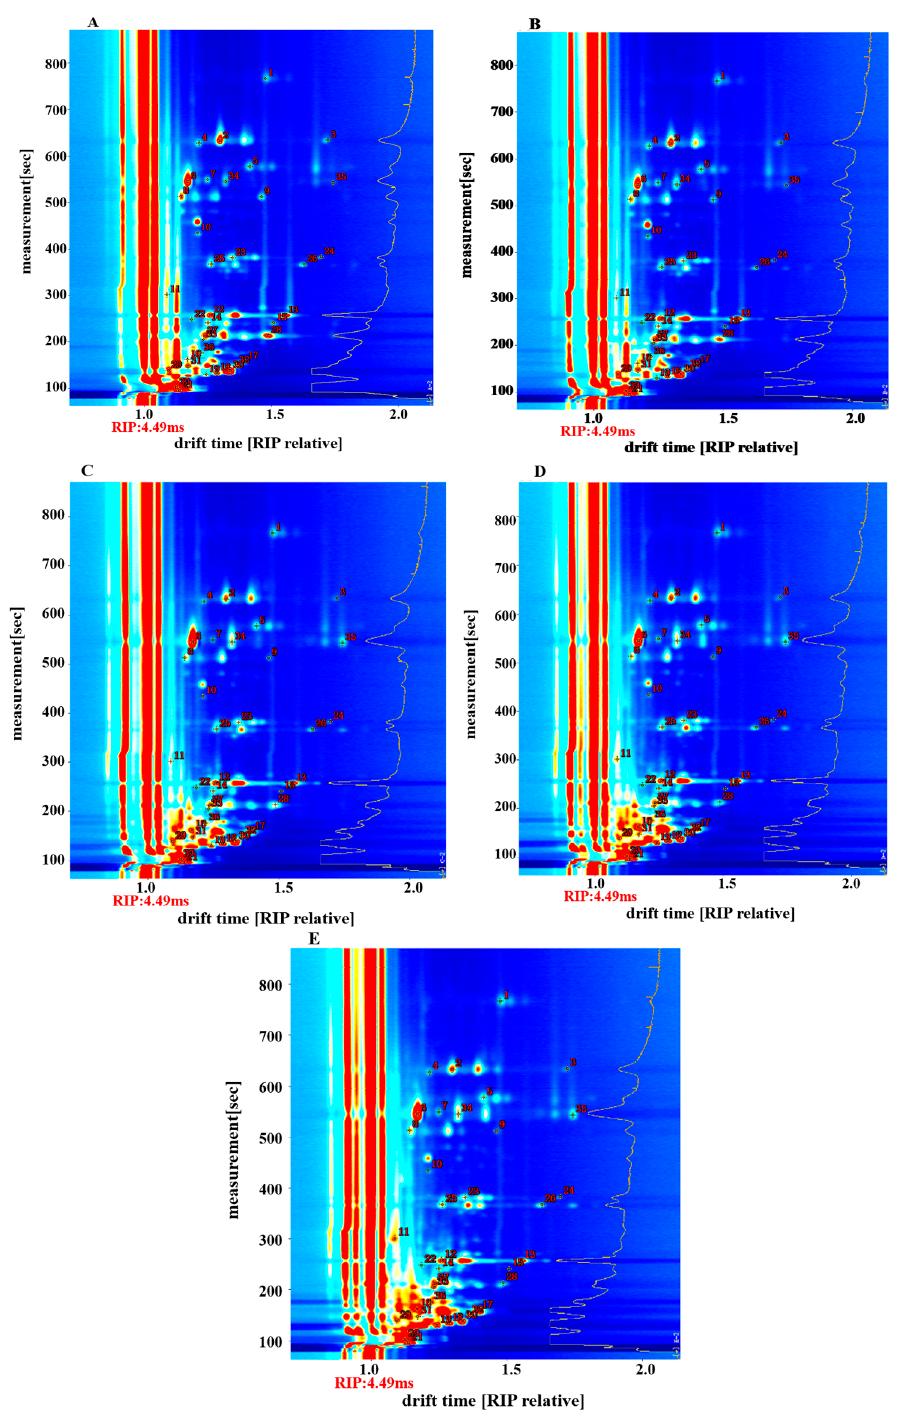
Figure 4. Qualitative analysis by GC-IMS of volatile flavor compounds in tilapia fish cakes with different treatments methods. ( A ) untreated fish cake; ( B ) drying treatment fish cake; ( C ) 105 °C sterilization fish cake; ( D ) 115 °C sterilization fish cake; ( E ) 121 °C sterilization fish cake. The lines represented the drift time of volatile components. Each number represented a compound.